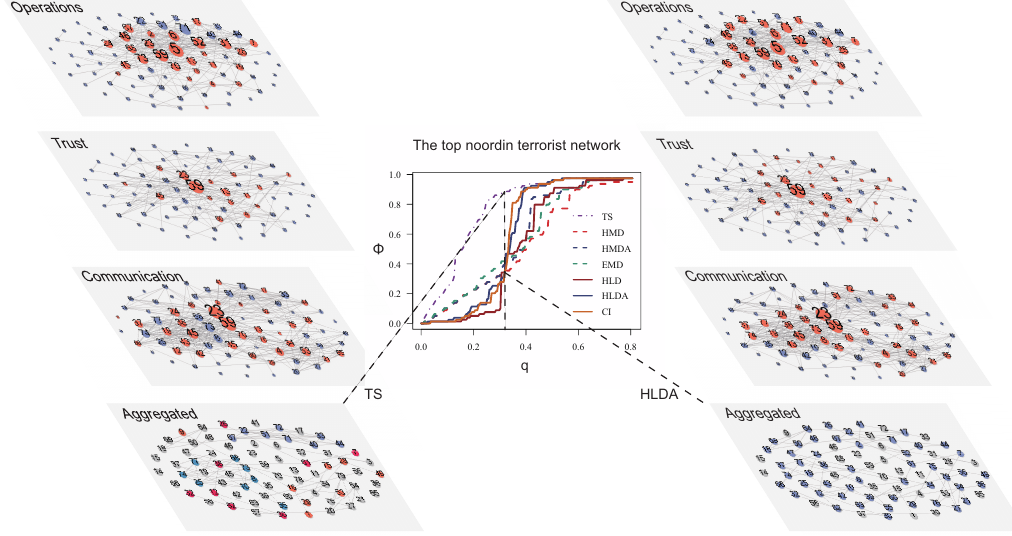
Figure 6. Optimal disintegration strategies in the three-layer top Noordin extremist network under layer node-based attack. For the TS algorithm, use the maximum value of Φ in 20 independent realizations. The left side of the figure shows the layer nodes (the orange nodes in the first three layers) included in the optimal disintegration strategy when the percentage of node removed is about 0.32 (where Φ = 0.886). The size of the nodes is determined by their layer degree. At the bottom, we give the aggregated network of the multiplex network after nodes removed in the fourth layer, where four giant components with size 8 are in different colors. Similarly, we present a visualization of the HLDA strategy on the right side of the figure (where Φ = 0.316 and the size of the giant component in the aggregated network is